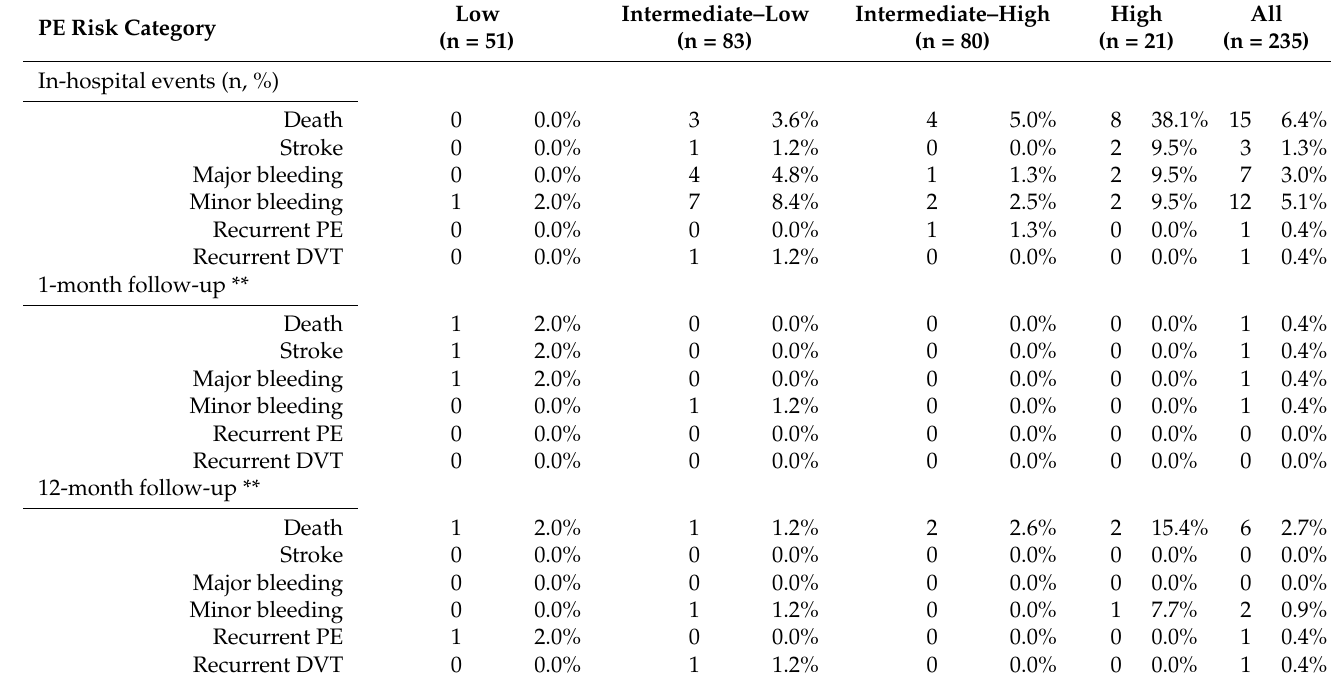
Table 4. In-hospital, 1-month and 12-month follow-up outcome events according to the mortality risk